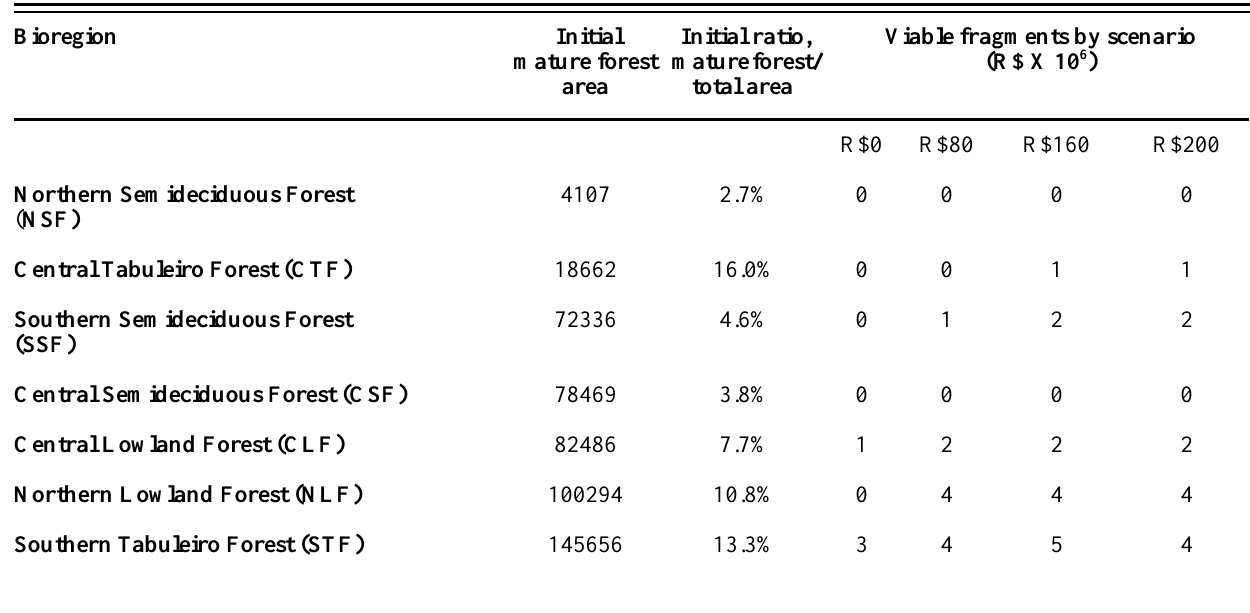
Initial ratio, Viable fragments by scenario mature forest mature forest/ (R$ X 10 6 ) area total area R$0 R$80 R$160 R$200 4107 2.7% 0 0 0 0 72336 4.6% 0 1 2 2